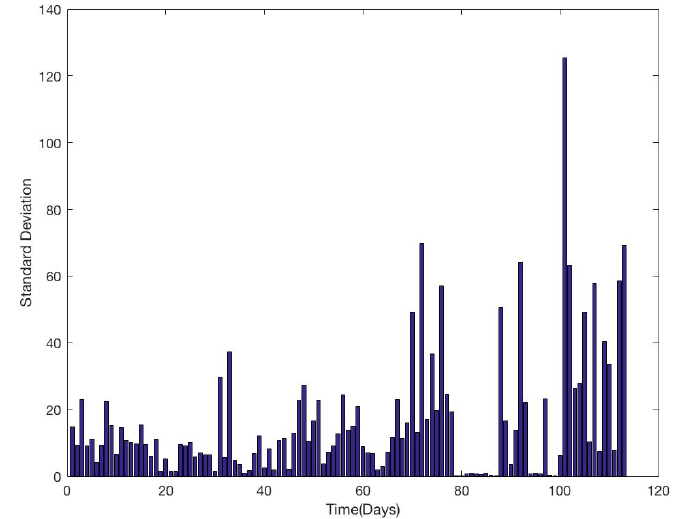
Figure 5. Standard deviations for ammonia measurements calculated per day of the EnBW campaign.